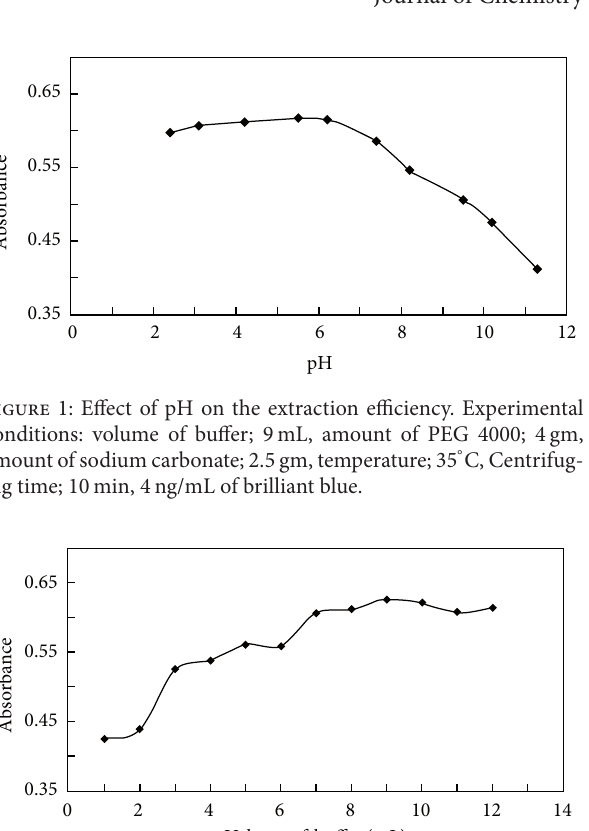
F 2: Effect of volume of buffer on the extraction efficiency. Experimental conditions: pH of sample; 5.5, amount of PEG 4000; 4gm, amount of sodium carbonate; 2.5gm, temperature; 35 Centrifuging time; 10min, 4ng/mL of brilliant